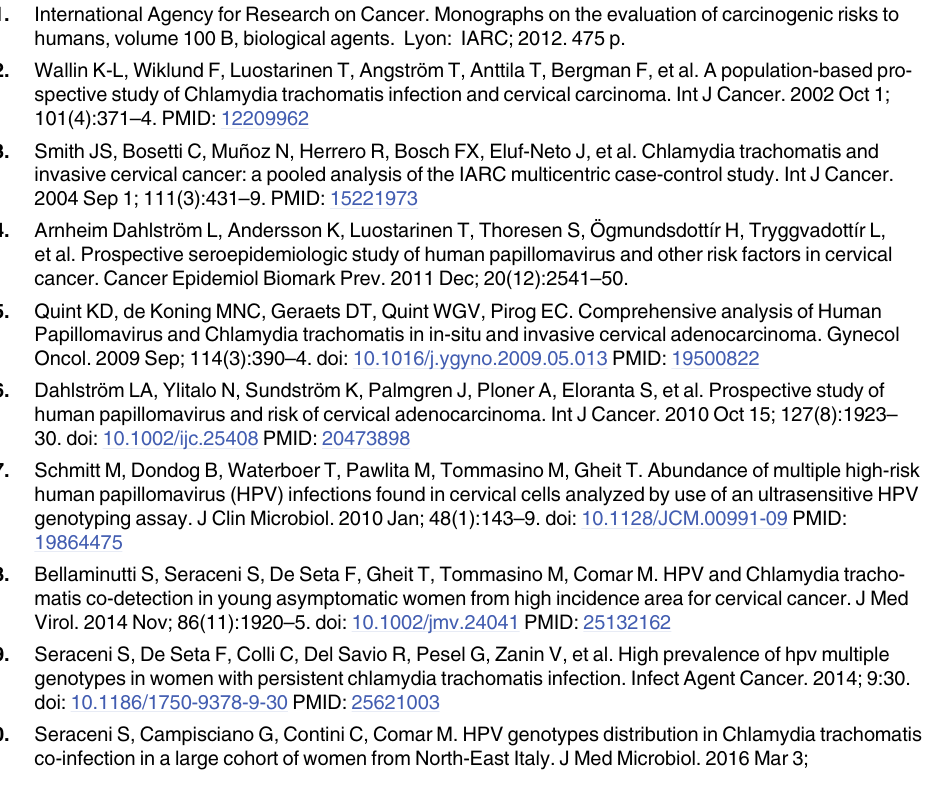
S1 Table. The analysis dataset on the detection of Chlamydia trachomatis and human papil- lomavirus (HPV) infections in women with cervical adenocarcinoma. SubjectID –